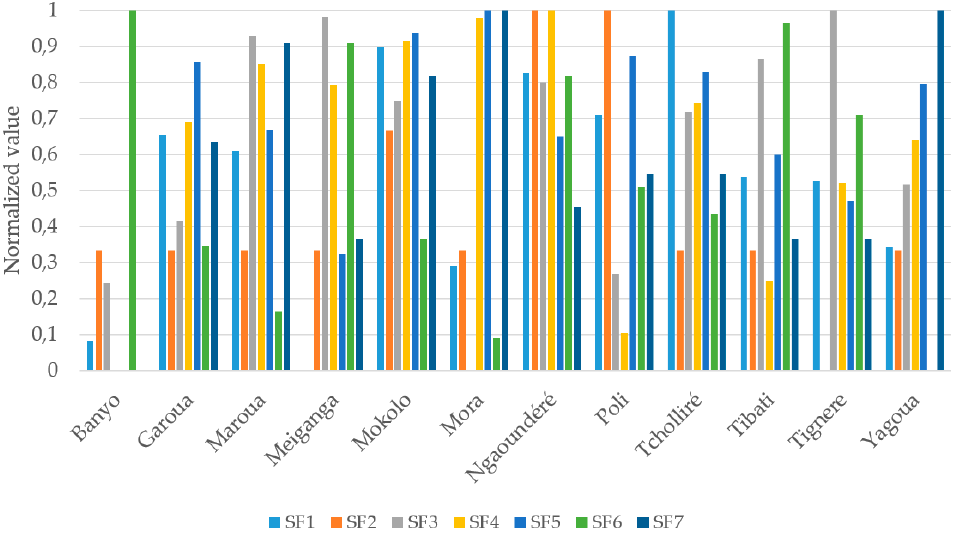
Figure 7. Normalized values of the suitability factors at each site.